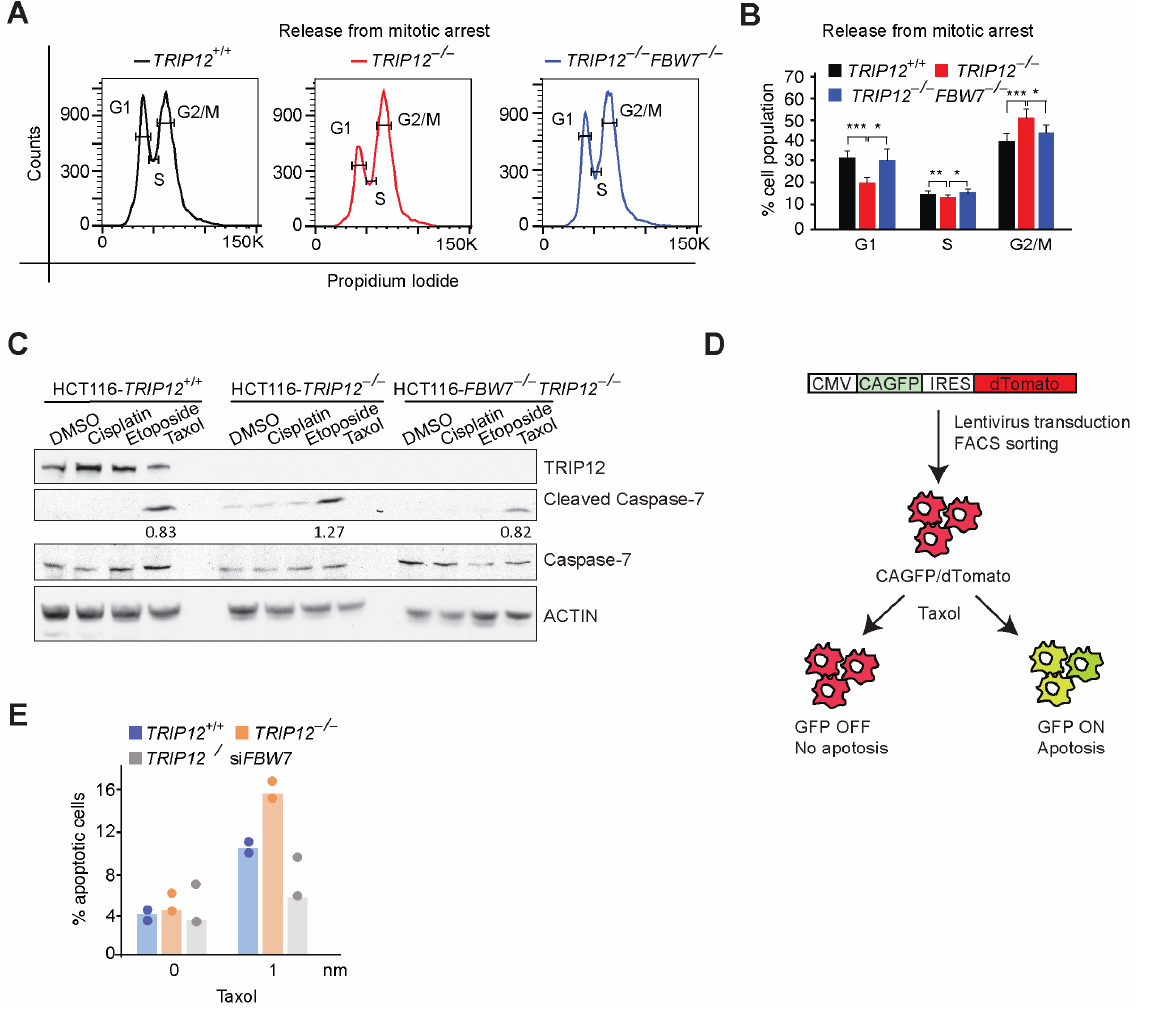
Figure 3. Aberrant release from mitosis in TRIP12 ‐ depleted cells: ( A ), Histogram of cells with indi– cated genotypes, synchronized in mitosis and released in normal media. ( B ) Quantification from experiments in ( A ). ( C ) Western blot for indicated antibodies showing cleaved caspase-7/total caspase- 7 ratio in cells from indicated genotypes. ( D ) Schematic for generation of a CA-GFP fluorescent apoptosis reporter. ( E ) Quantification of FACS data from stable cell lines expressing lentivi ‐ rus ‐ mediated CA ‐ GFP in cells from indicated genotypes. * p < 0.05, ** p < 0.01, and *** p < 0.001.